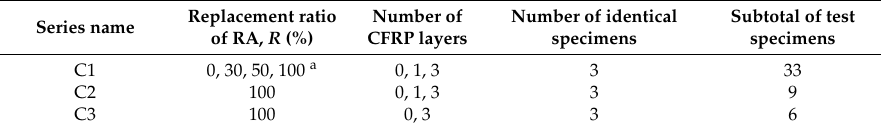
Table 2. Specimen details.